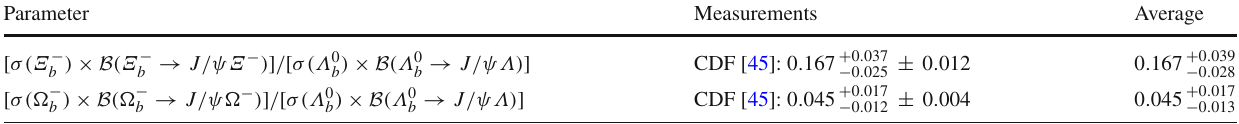
and (cid:21) − decays to charmonium b b